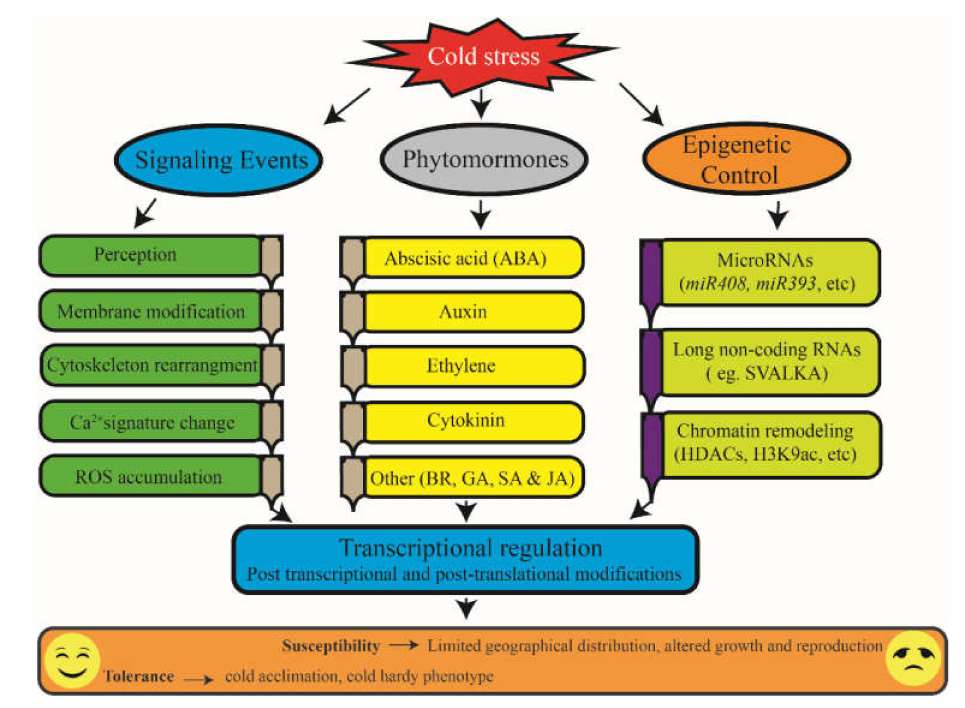
Figure 1. Significant events during cold stress response in